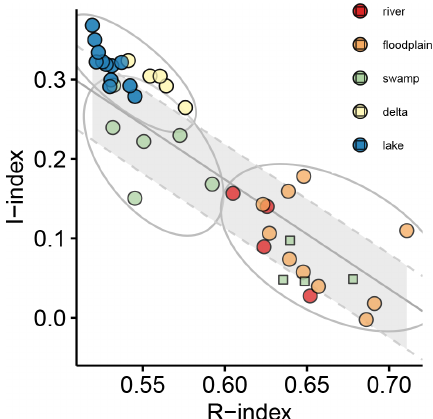
Figure 6. I/R diagram. Symbol colors reflect the sub-environment (see Fig. 1 and Sect. 3.1.1) origin of the sedimentary organic matter: red denotes upper reach; orange denotes floodplain; green denotes swamp; yellow denotes delta; blue denotes lake. The grey-shaded area bordered by dashed grey lines refers to the linear regression describing the continuum from biological tissue to a mixture of de- composition constituents (decomposition line; Malou et al., 2020). Green circles and squares denote splitting up of swamp samples into groups of differing degradation state, while grey-bordered ellipses indicate more general splitting of the data set into groups regardless of their depositional